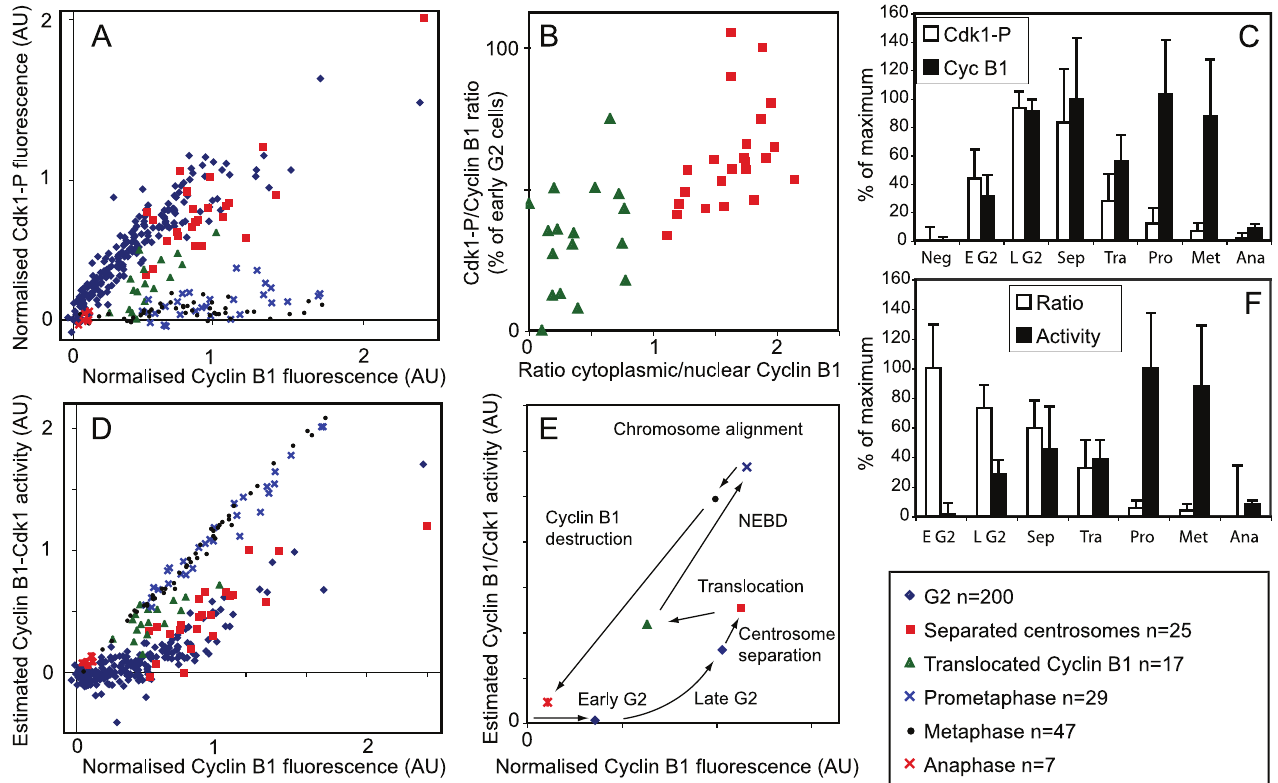
Figure 2. Gradual Dephosphorylation of Cdk1 in Mitotic Entry (A) Quantification of immunofluorescence labeling. Cytoplasmic Cdk1-P ( y -axis) and cyclin B1 signal ( x -axis) were quantified in the cytoplasm of unsynchronized cells. Each dot corresponds to one cell. Cells were labeled according to morphology and staining as follows: cells with cytoplasmic cyclin B1 (blue diamonds), cytoplasmic cyclin B1 and separated centrosomes (red squares), predominant cyclin B1 staining in nucleus (green triangles), condensed DNA and no distinguishable nucleus in cyclin B1 staining (light blue Xs), all chromosomes aligned on a metaphase plate (black dots), and anaphase (red Xs). (B) Relative cyclin B1–Cdk1-P during nuclear translocation. Ratio of cytoplasmic Cdk1-P and cyclin B1 signal ( y -axis) in cells with separated centrosomes (red squares) and translocated cyclin B1 (green triangles) correlated with the ratio of nuclear and cytoplasmic cyclin B1 ( x -axis). The average cytoplasmic Cdk1-P/cyclin B1 ratio of early G2 cells is defined as 100%. Early G2 cells are defined as cells with cytoplasmic cyclin B1 levels between average anaphase cyclin B1 levels and lowest cyclin B1 level of cell with separated centrosomes. (C) Average values of cytoplasmic cyclin B1 and phosphorylated Cdk1. Values are shown as percentage of the highest average. Error bars indicate SD. Neg, cells used for background subtraction; E G2, G2 cells with cyclin B1 levels between average anaphase levels and lowest value of cell with separated centrosomes; L G2, G2 cells with cyclin B1 levels above lowest value of cell with separated centrosomes; Sep, separated centrosomes; Tra, translocated cyclin B1; Pro, prometaphase; Met, metaphase; Ana, anaphase. (D) Estimated cytoplasmic cyclin B1/Cdk1 activity of individual cells. The degree of dephosphorylation multiplied with the level of cyclin B1 ( y -axis), as a function of the level of cyclin B1 ( x -axis). Cells are labeled as in (A). (E) Average values of estimated cytoplasmic cyclin B1–Cdk1 activities within the distinct phases, shown in Figure 3D, as a function of cytoplasmic cyclin B1 levels. (F) Average values of cytoplasmic Cdk1-P/cyclin B1 ratio and estimated cytoplasmic cyclin B1–Cdk1 activities in the different phases. Values are shown as percentage of the highest average. Error bars indicate SD. Labels are as in Figure